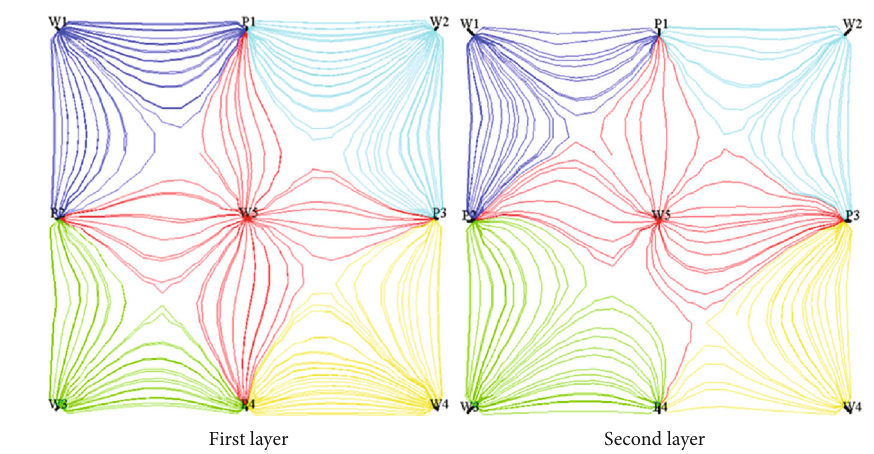
Figure 2: Model permeability fi